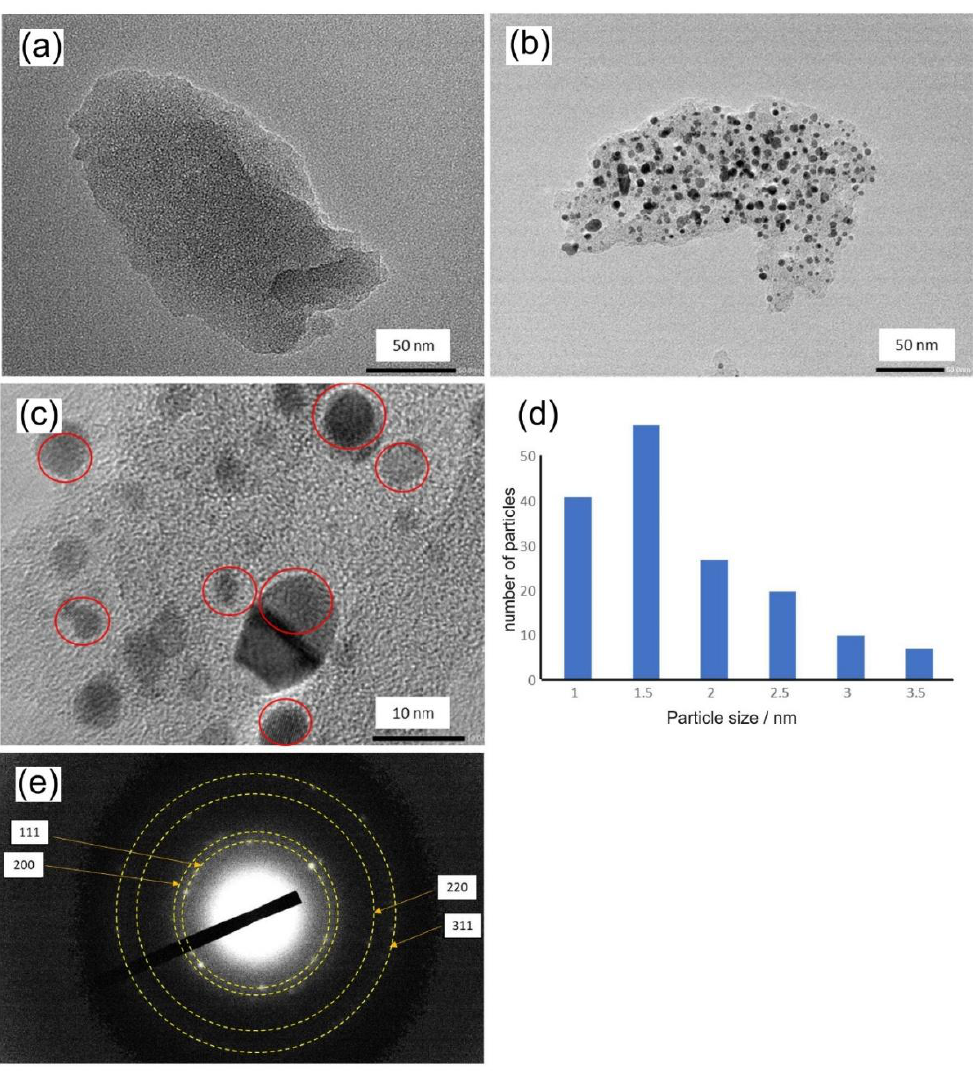
Figure 2. Transmission electron microscopy images for ( a ) carbonized hexachloroplatinate loaded polymer of intrinsic microporosity (PIM-EA-TB-H 2 ), ( b ) carbonized PIM-EA-TB-H 2 with embedded nano-platinum, ( c ) high magnification micrograph showing platinum crystal lattice planes, ( d ) particle size distribution analysis, and ( e ) electron diffractogram with characteristic hkl reflections for platinum face-centered cubic phase.